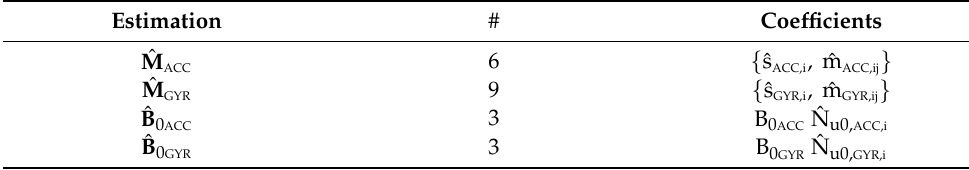
Table 10. Results of calibration